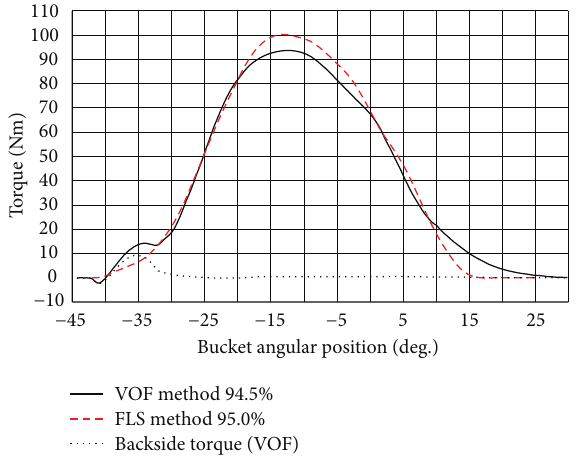
Figure 19: Comparison of VOF and FLS methods for a new modified runner